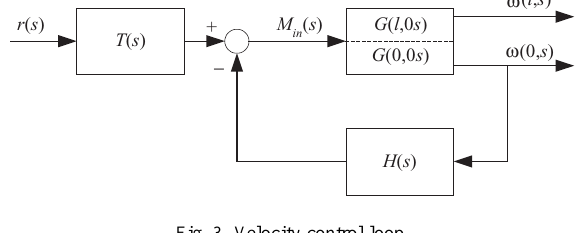
Fig. 3. Velocity control